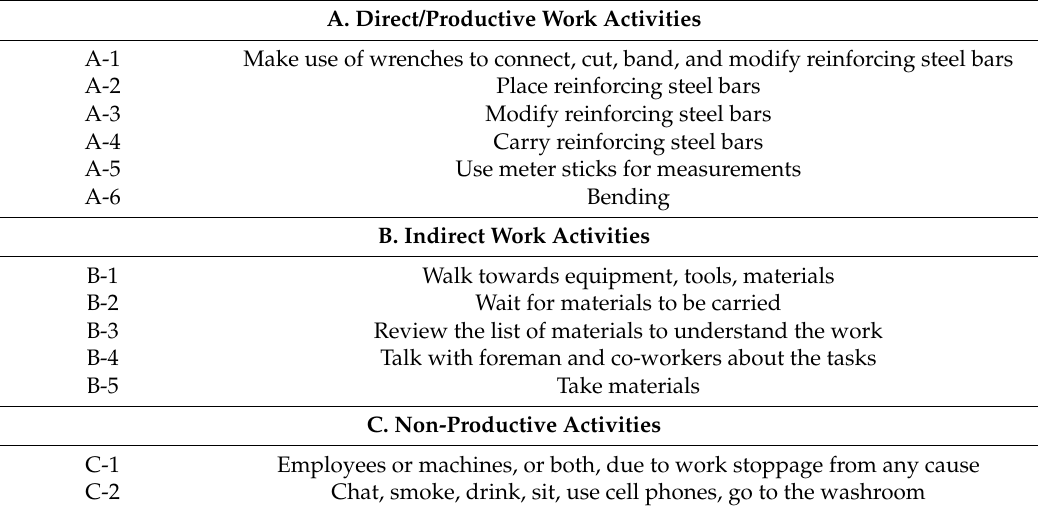
Table 1. Breakdown of direct, indirect, and non-productive work